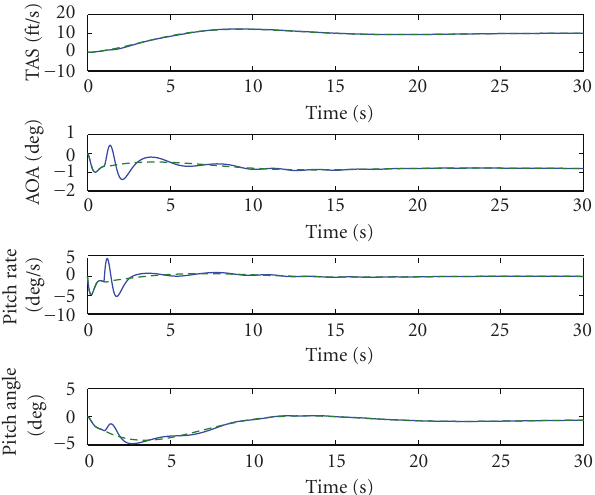
Figure 15: Time history of plant state (solid) and reference model state (dashed).